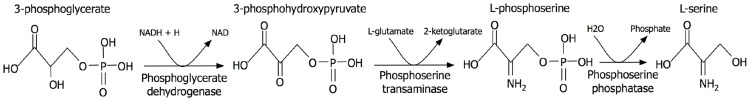
Pathway for L-serine production in E. coli.